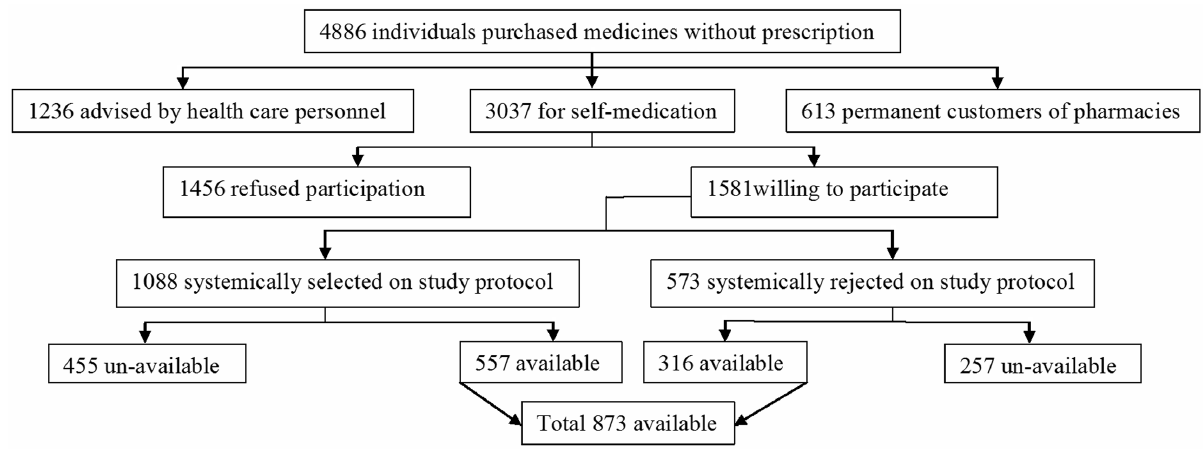
Fig 1. An outline of